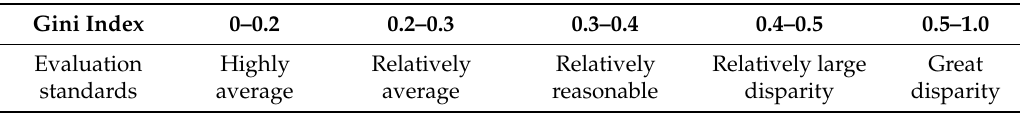
Table 2. Grading of Gini